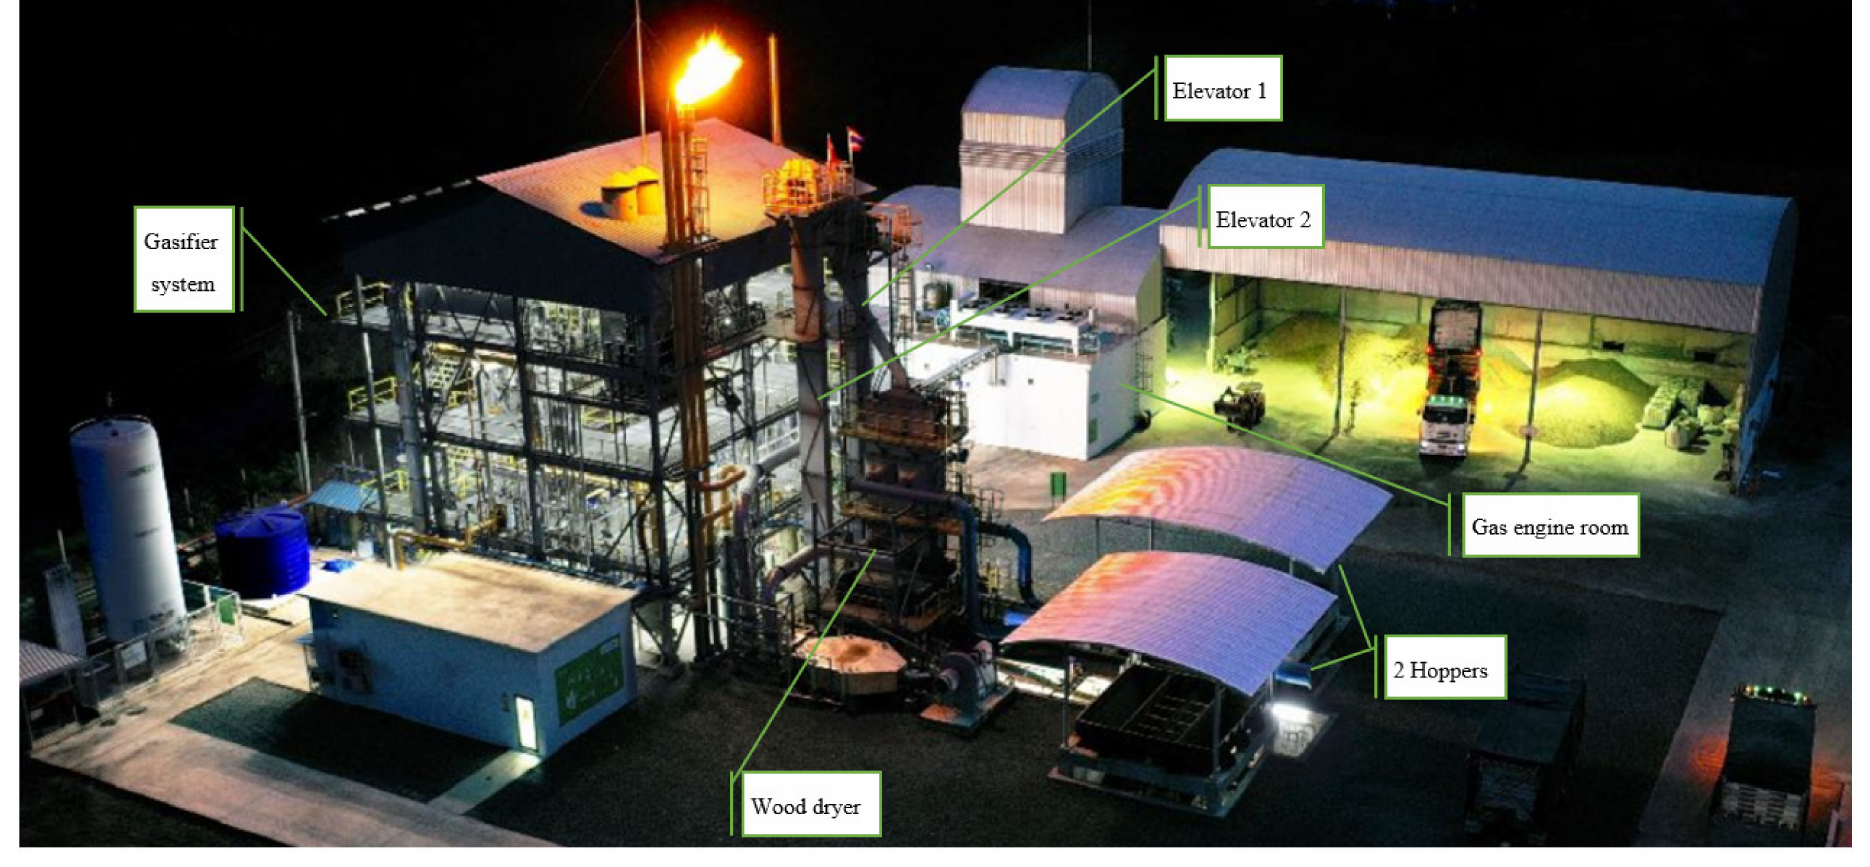
Figure 4. Nong Bua DFB gasifier power